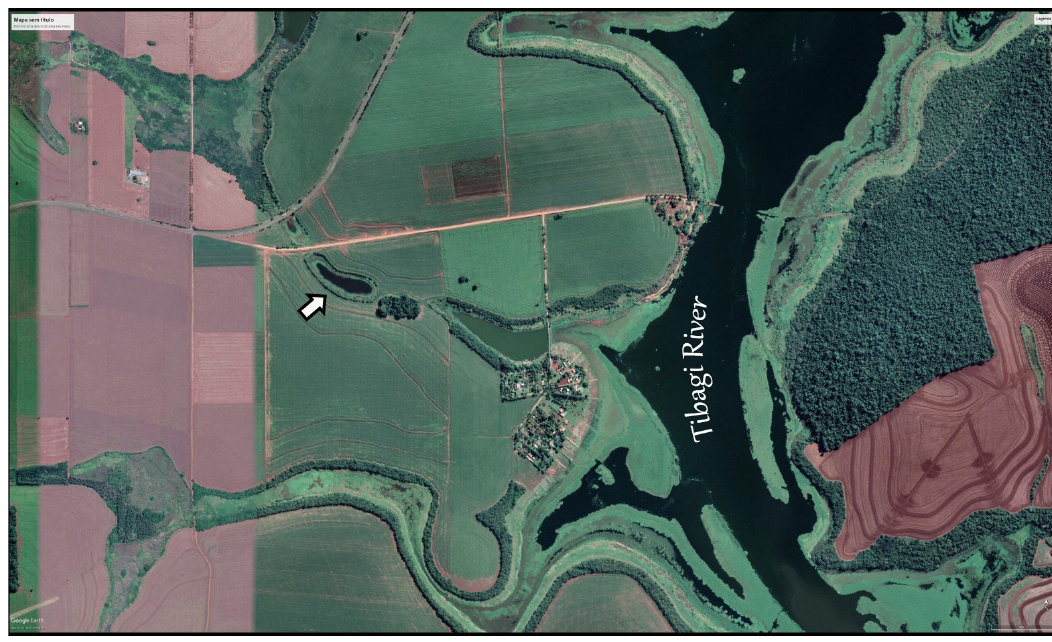
Figure 2. Satellite image showing the studied marginal lagoon (white arrow) at the left margin of the Tibagi River, Municipality of Sertanópolis – PR, Source: Google Earth.